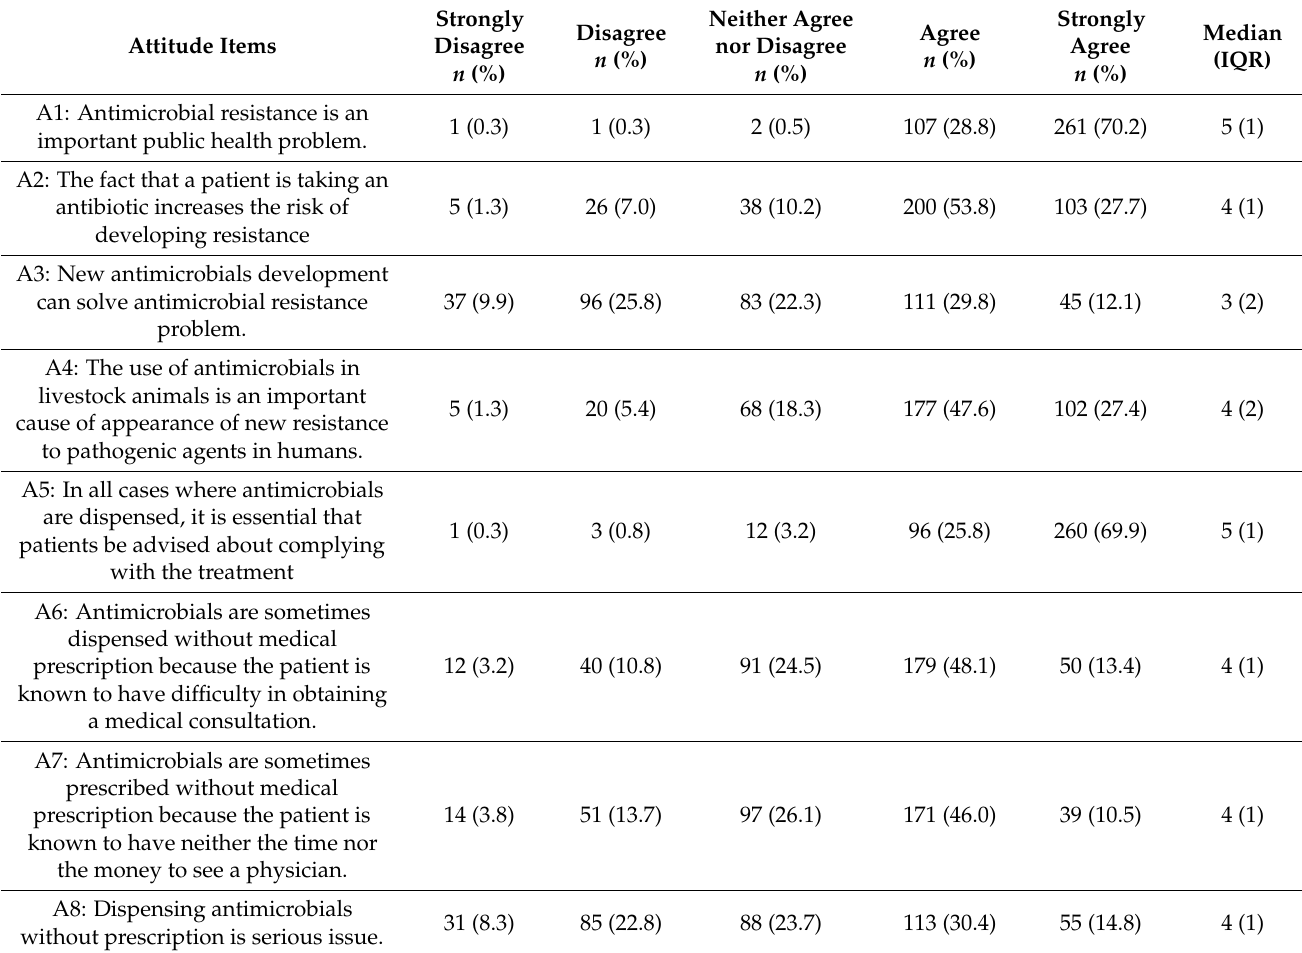
Table 3. Community pharmacists’ responses to attitude